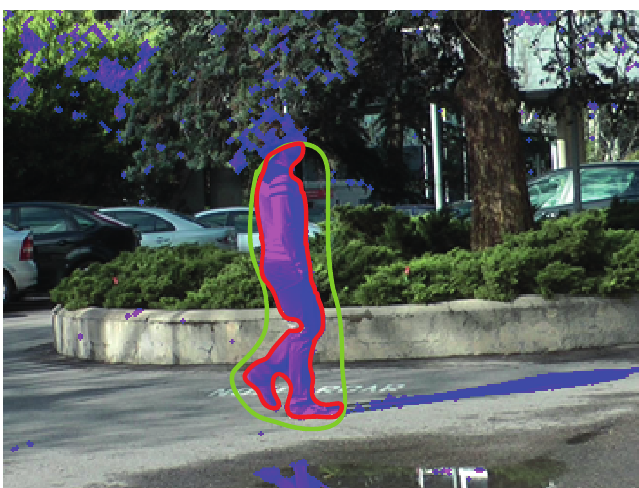
Figure 8. Example of using the intelligent mode combined with the motion detection tool. The difference mask is shown in semitransparent purple. The contour drawn by the user with the intelligent mode is shown in red. The contour resultant from the combination of the motion mask and the contour manually drawn is shown in